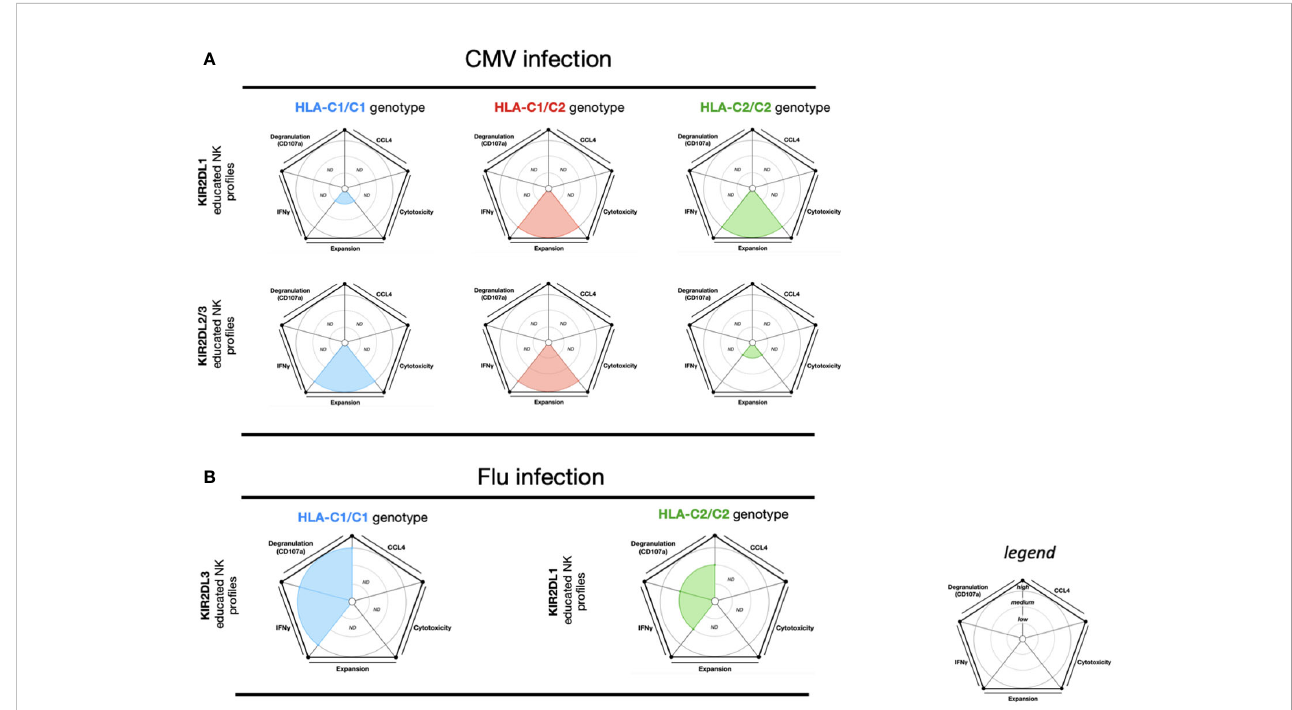
FIGURE 3 NK cell education pro fi les related to CMV and In fl uenza viral infections. The different colors each represent a speci fi c-NKR educated NK pro fi le. Each educated NK pro fi les are de fi ned by fi ve factors (degranulation, CCL4, IFN g , cytotoxicity, and expansion). Each factor is described by the size of its slice on the pie chart according to three levels of reactivity (low, medium, and high). (A) KIR2DL1 educated NK cells and KIR2DL2/3 educated NK cells present respectively three educated NK pro fi les according to HLA-C1/C1, HLA-C1/C2, and HLA-C2/C2 genotypes. The NK educated reactivity represented in these charts was adapted via in vitro CMV-infected fi broblast stimulation (78, 81). (B) KIR2DL1 educated NK cells and KIR2DL3 educated NK cells each present a distinct educated NK pro fi le according to the HLA-C1/C1 and HLA-C2/C2 genotypes, respectively. The NK educated reactivity represented in these charts was adapted via in vitro in fl uenza A infected CD3-depleted PBMC cells stimulation (82). ND, no data is